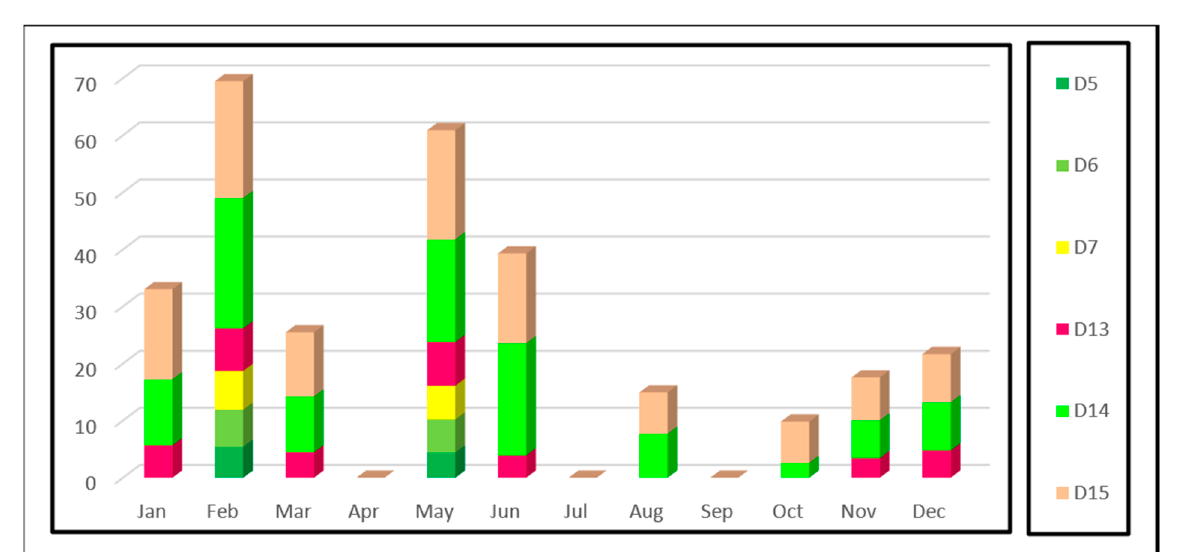
Table 12. Monthly unmet demands (MCM) of lining four